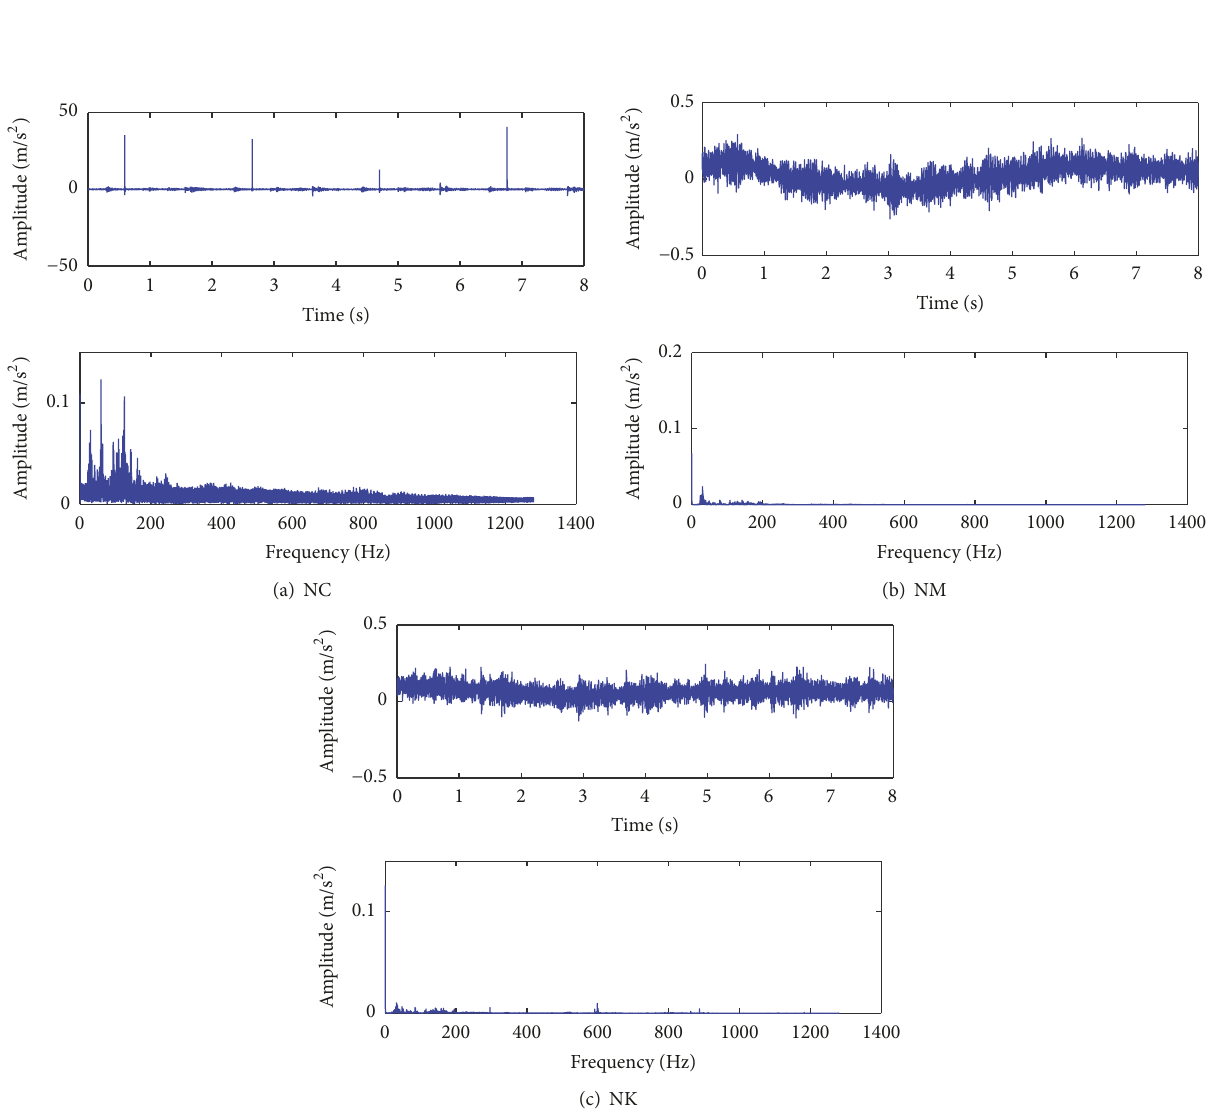
Figure 4: The experiment platform of check valve.